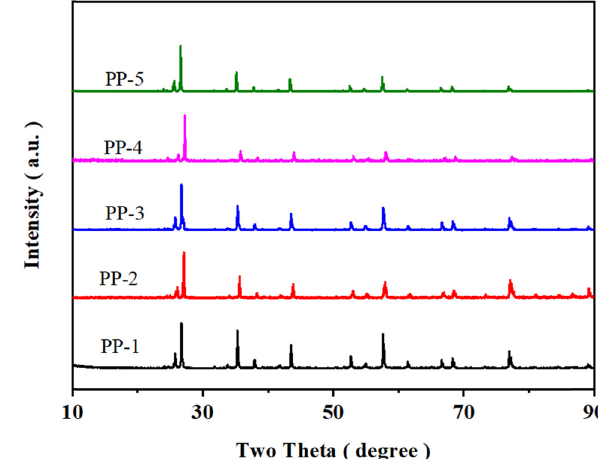
Figure A2: E ff ect of di ff erent EG and Al 2 O 3 ratios on XRD of PP composites.